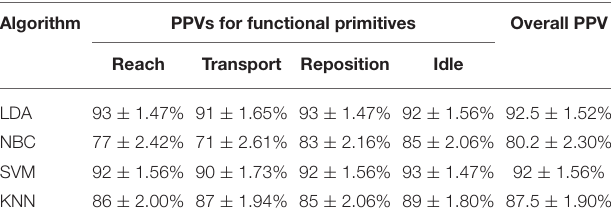
TABLE 2 | Classification performance of machine learning algorithms for functional primitives. Algorithm PPVs for functional primitives Overall